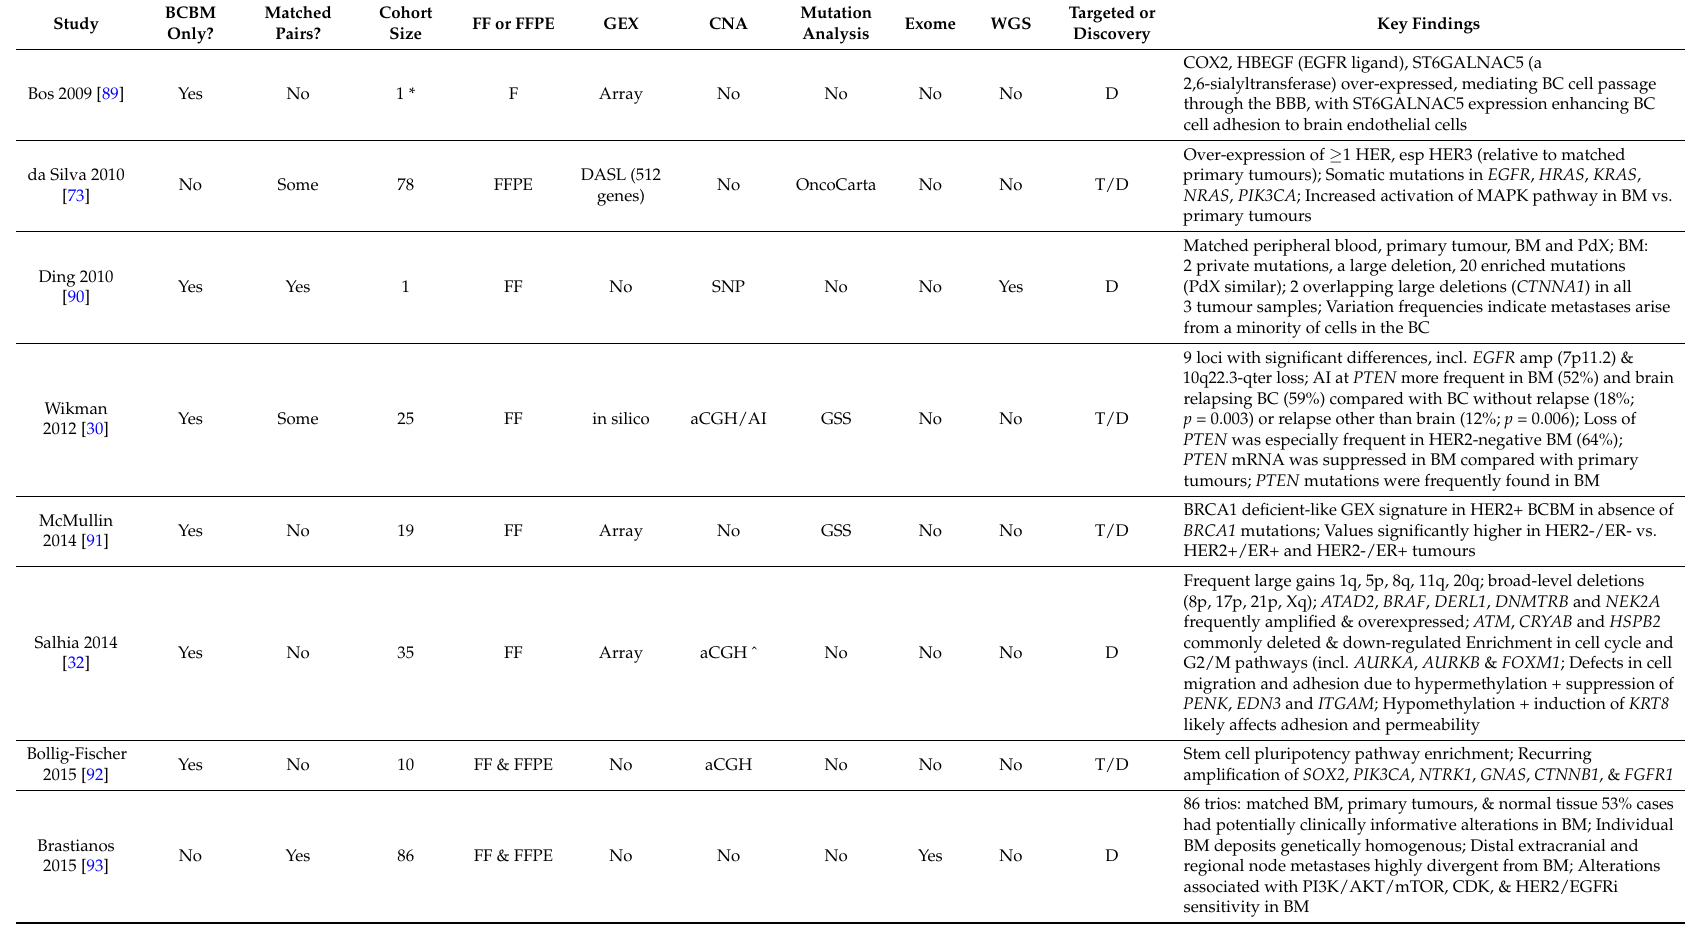
Table 2. A catalogue of brain metastasis genomic